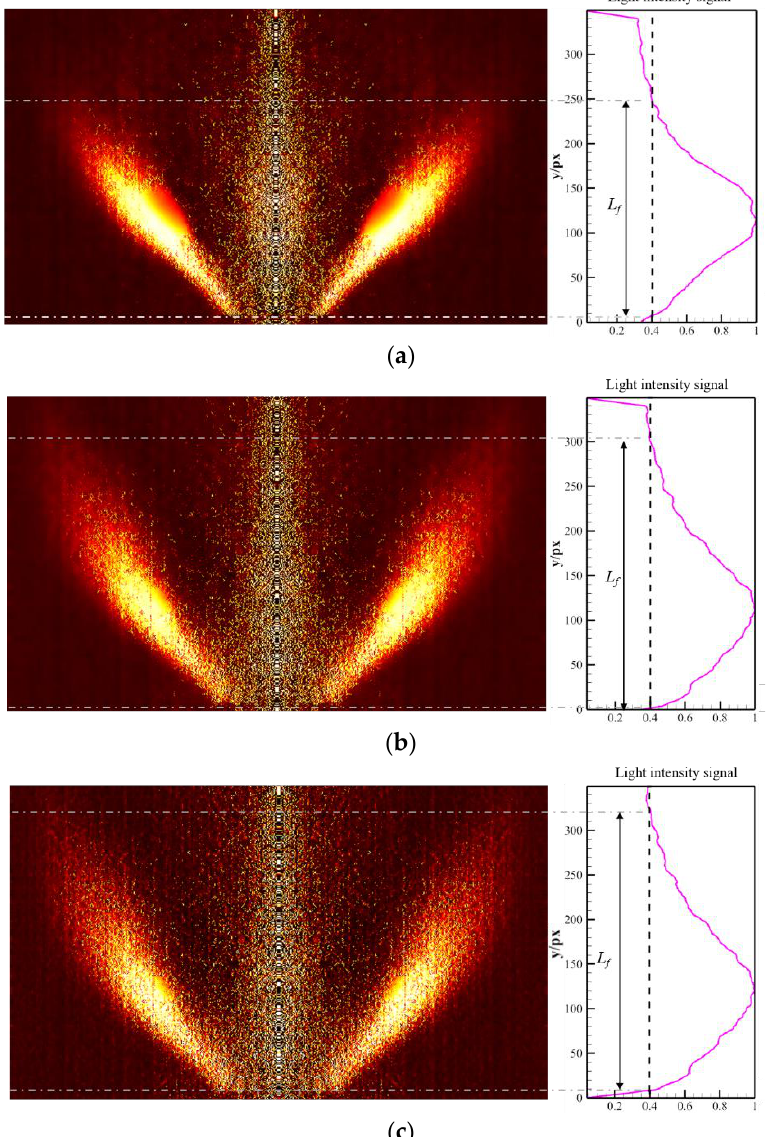
Figure 12. Flame structure and axial light intensity distribution under different swirler structures. ( a )swirler A; ( b ) swirler B; ( c ) swirler C.